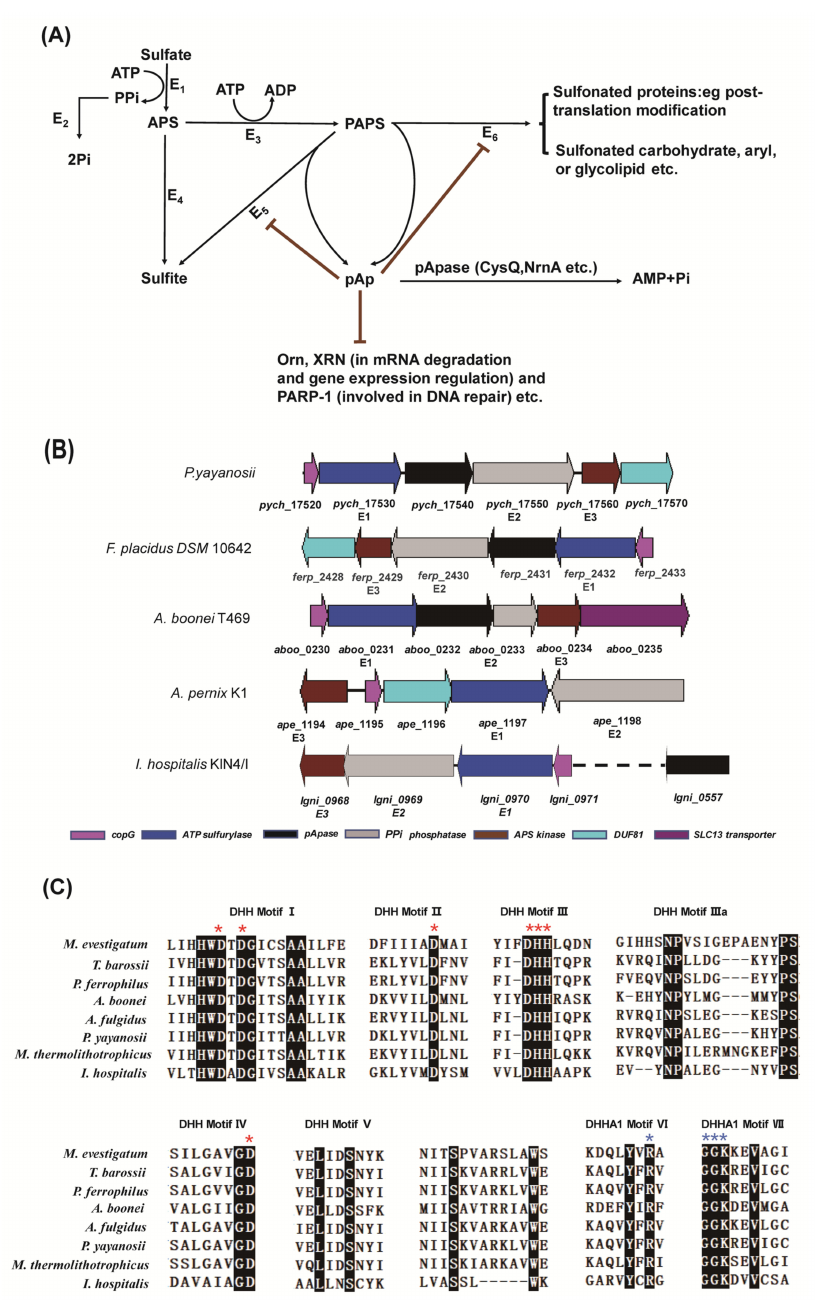
Figure 1. Archaeal sulfate assimilation pathway and function of pApase. ( A ) Archaeal sulfate assimilation pathway candidate in cells. Enzymes are shown alongside the black arrows (E1: ATP sulfurylase; E2: PPi phosphatase; E3: APS kinase; E4: APS reductase; E5: PAPS reductase; and E6: sulfotransferase), and the brown lines indicate inhibition by pAp. ( B ) Conserved gene cluster involved in the sulfate assimilation pathway and auxiliary genes in Euryarchaeota and Crenarchaeota. Information for strains and related genes are as follows: P. yayanosii CH1 ( pych_17520 to 17570 ), Ferroglobus placidus DSM 10642 ( ferp_2428 to 2433 ), Aciduliprofundum boonei T469 ( aboo _ 0230 to 0235 ), A. pernix K1 ( ape _ 1194.1 to 1198.1 ) and Ignicoccus hospitalis KIN4/I ( igni _ 0968 to 0971 and igni _ 0557 ). ( C ) Multi-alignment of the conserved motifs of pApases from different archaeal strains, including Methanohalobium evestigatum Z-7303 (Metev_1146), Thermococcus barossii (A3L01_09430), Palaeococcus ferrophilus (WP_048150725.1), Aciduliprofundum boonei T469 (Aboo_0232), Methanothermococcus thermolithotrophicus (WP_018153796.1) and P. yayanosii CH1 (PYCH_17540), Archaeoglobus fulgidus (AF_0291), and Ignicoccus hospitalis KIN4/I (Igni_0557). The alignment was performed using ClustalW, and the completely conserved residues are shaded in dark. The mutated conserved residues for coordinating metal ions (D10, D12 D59, D77, H78, H79, and D126) and binding substrates (R259, G285, G286, and R287) are indicated with red and blue asterisks, respectively, above the PyapApase